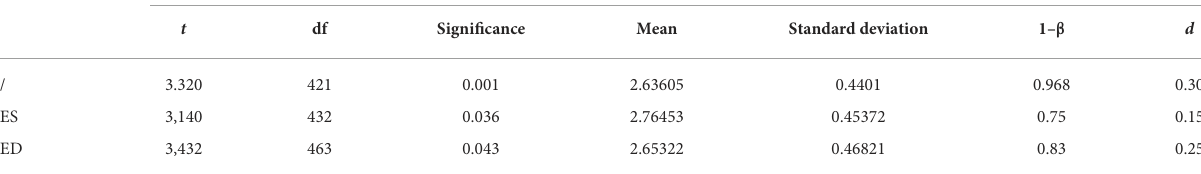
greater the square of the sum of factor load values, and the better the internal consistency is. Meanwhile, the Average Variance Extracted (AVE) represents the convergence validity calculated by the factor load. AVE value uses the sum of the squares of the factor load values to represent the comprehensive explanatory ability of the potential variables to all the measured variables. The larger the AVE is, the stronger the potential variables’ ability to explain their corresponding items simultaneously. Conversely, the stronger the ability of the items to represent the nature of the potential variables (converging to one point) is, the better the convergent validity is. The calculation results are portrayed